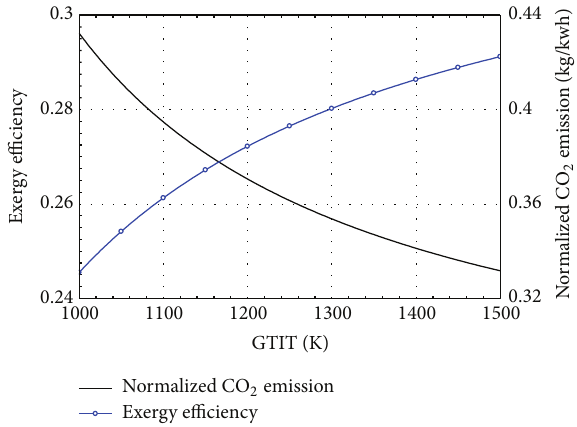
Figure 4: Variation with compressor pressure ratio of exergy effi- ciency and total exergy destruction rate.